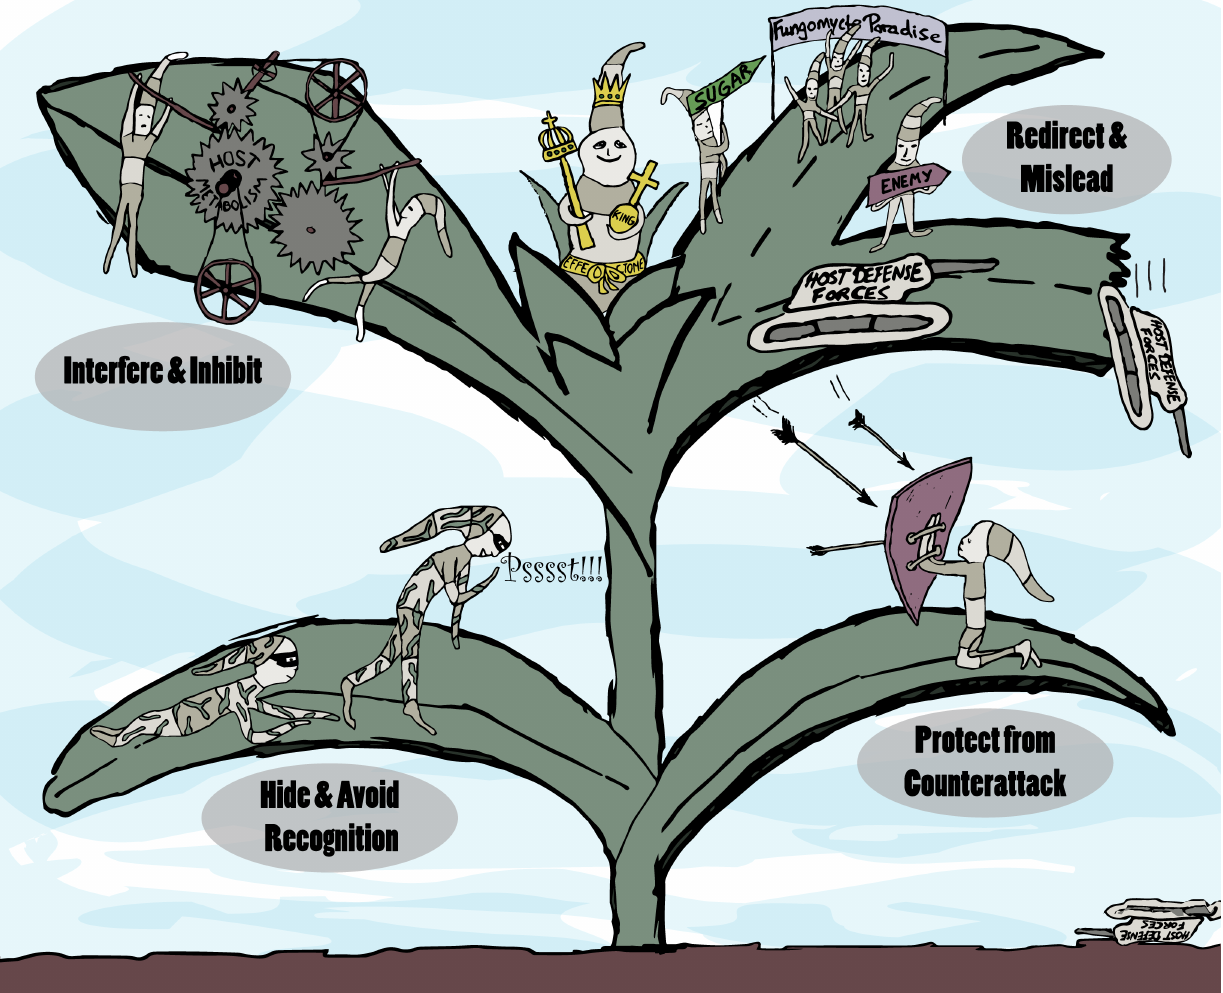
Fig 1. Strategies for successful host invasion. Plant-colonizing microbes employ effectors fulfilling various functions during the host invasion, which are visualized symbolically in this cartoon. Different modes of action (self-binding and self-modifying, activating or inhibiting activities) of effectors described in the text may be applied to serve the listed strategies (text on grey oval